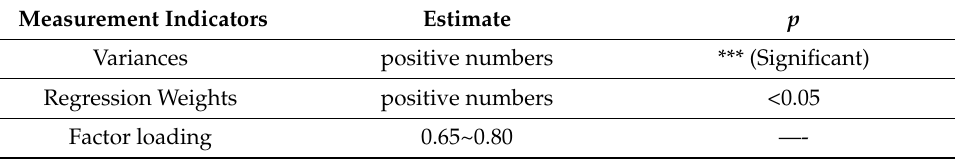
Table 7. Analysis of interpretation ability of latent variable